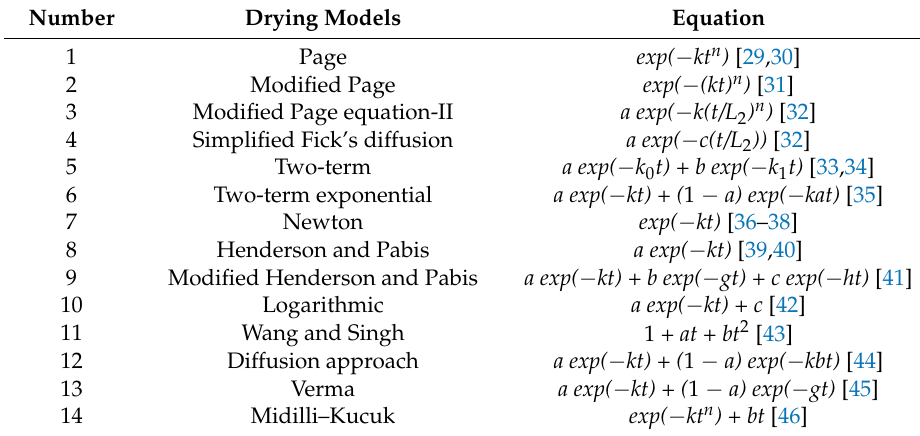
Table 1. Mathematical thin-layer drying models. Reproduced with permission from Zhu, J.-F. et al., Fuel Processing Technology; published by Elsevier [25].